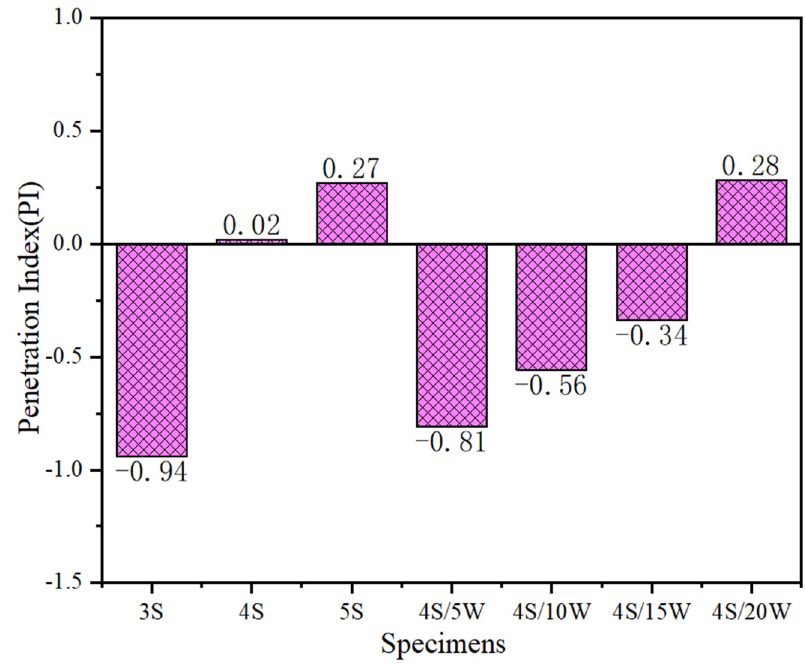
Figure 3. PI of Modified Asphalt.